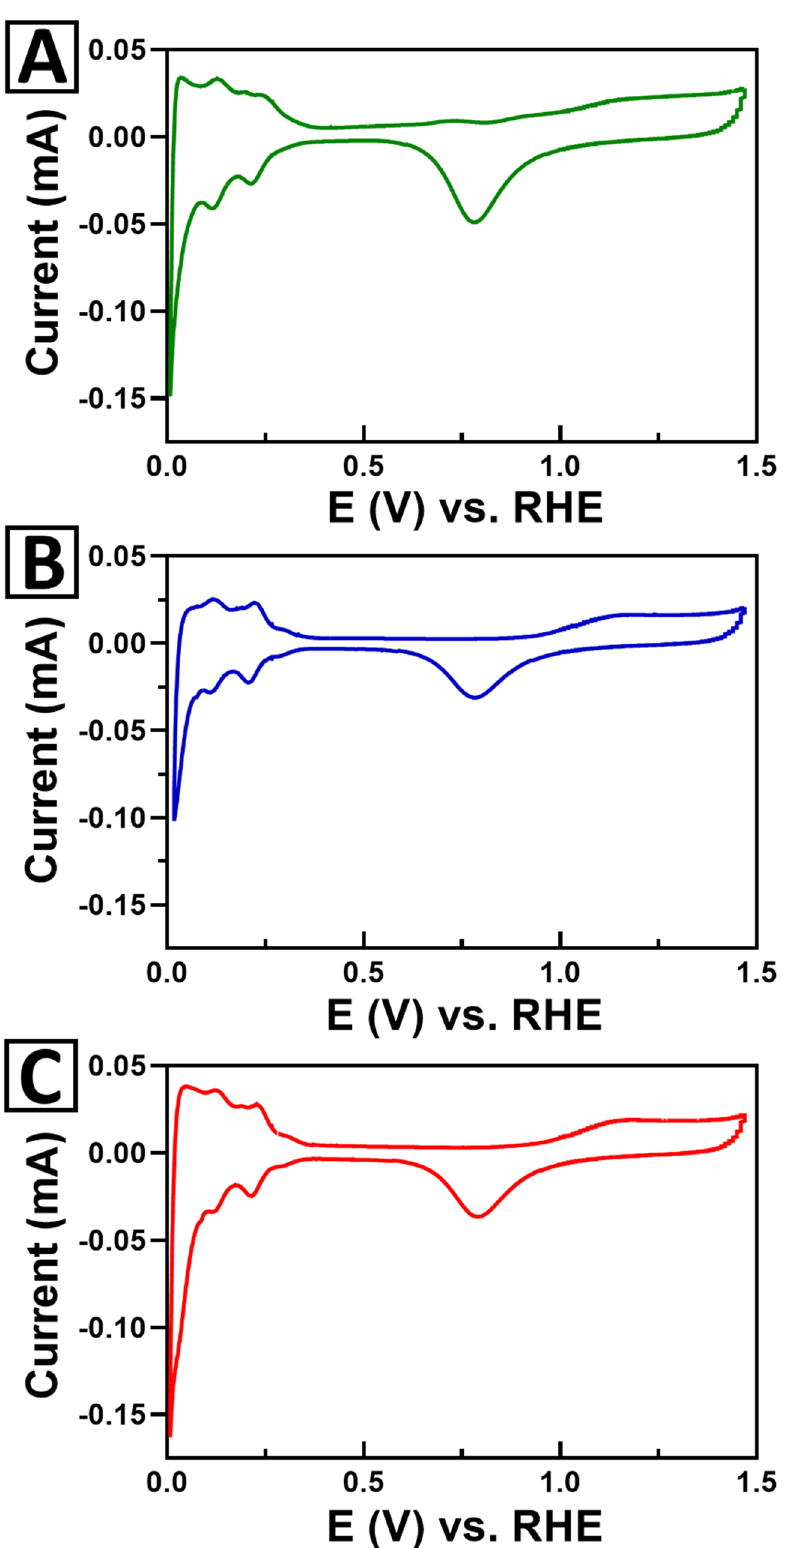
Figure 8. Cyclic voltammogram (CV) curves for 3D spheres of ( A ) Pt/CTO, ( B ) Pt/STO, and ( C ) Pt/BTO, respectively.